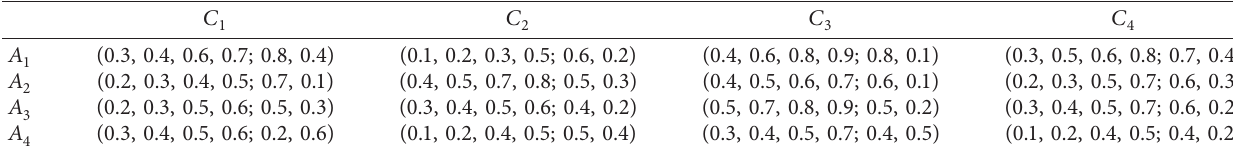
Table 4: Evaluation value matrix by expert